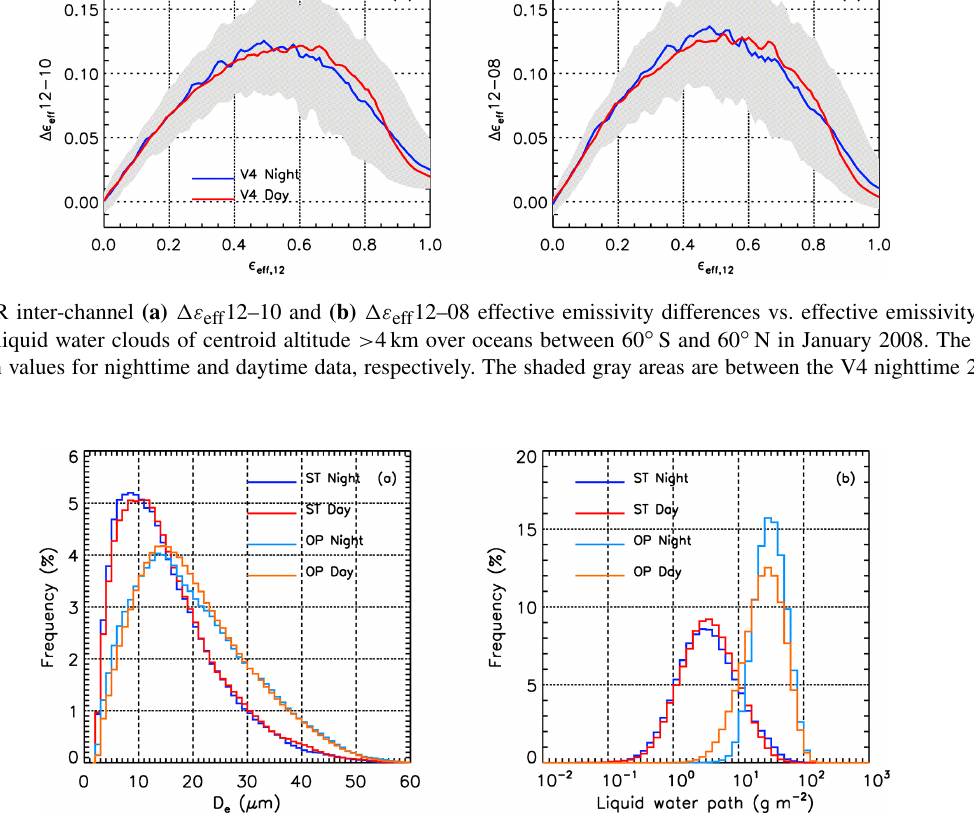
Figure 15. Histograms of V4 confident retrievals of (a) D e and (b) liquid water path in single-layered semi-transparent (ST; night: navy blue; day: red) and opaque (OP; night: light blue; day: orange) liquid water clouds of centroid altitude > 4km between 60 ◦ S and 60 ◦ N over oceans in January